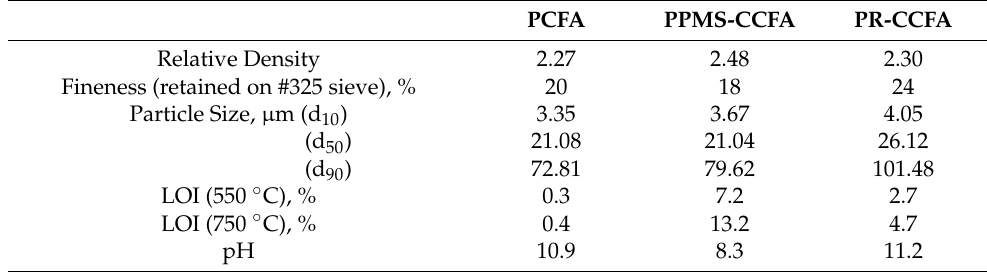
Table 2. Physical Properties of PCFA and